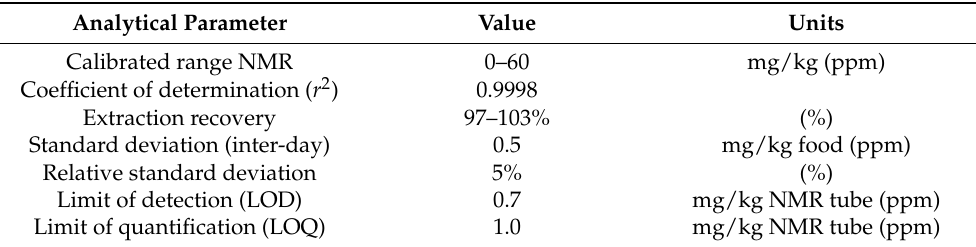
Table 1. Analytical parameters of the 1 H-NMR determination of poly(dimethyl)siloxanes in foods using BTMSB as internal standard (recovery rate and relative standard deviation is calculated for surimi fish food). For experimental details see Supplementary Materials.